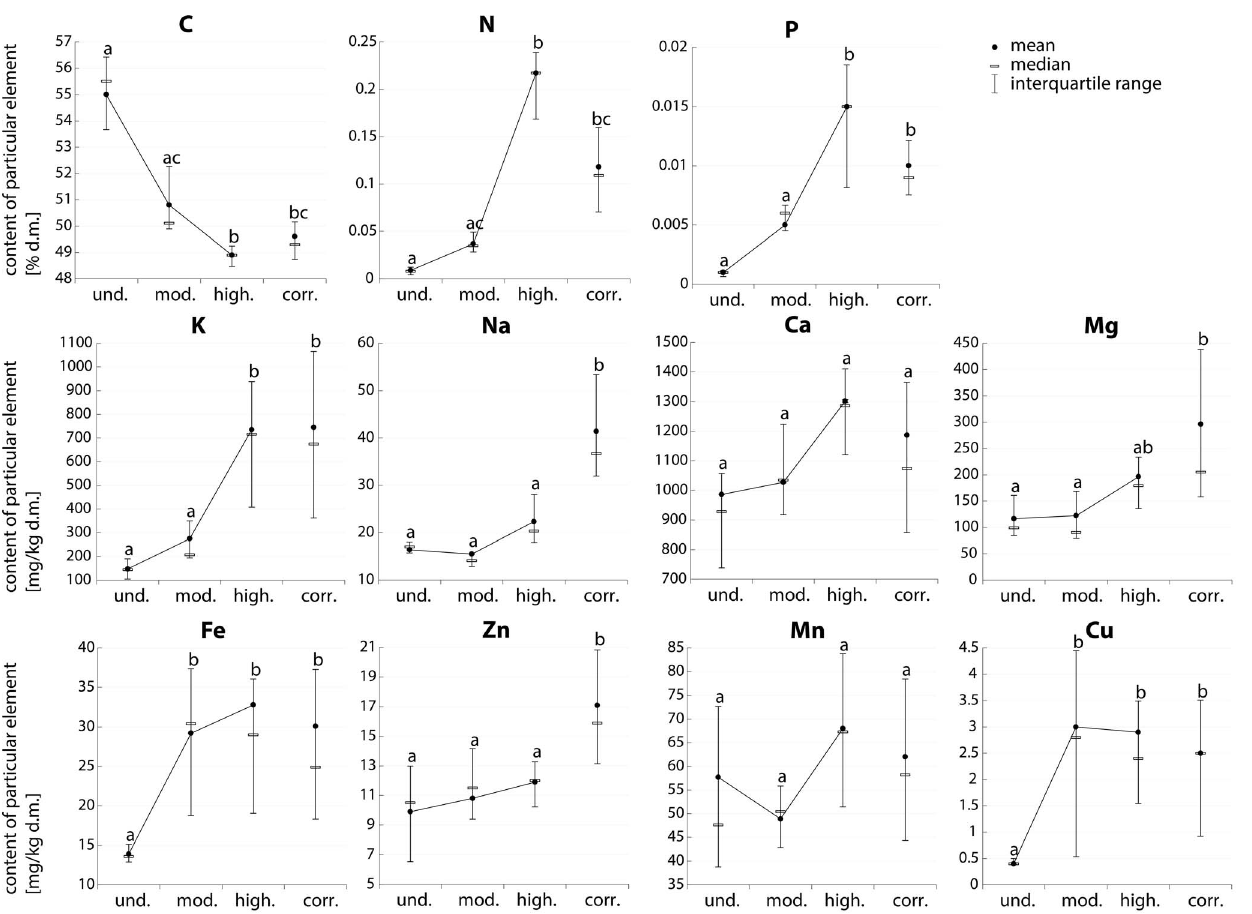
Fig. 4. Decay-related changes of elemental content in pine stumps inhabited by larvae. und. - undecayed wood; mod. - moderately decayed wood; high. - highly decayed wood; corr. - corridors (see text for definitions of wood decay categories). Values bearing the same letter do not differ significantly between wood decay categories (Kruskal-Wallis test, p , 0.05). For detailed results, see S1